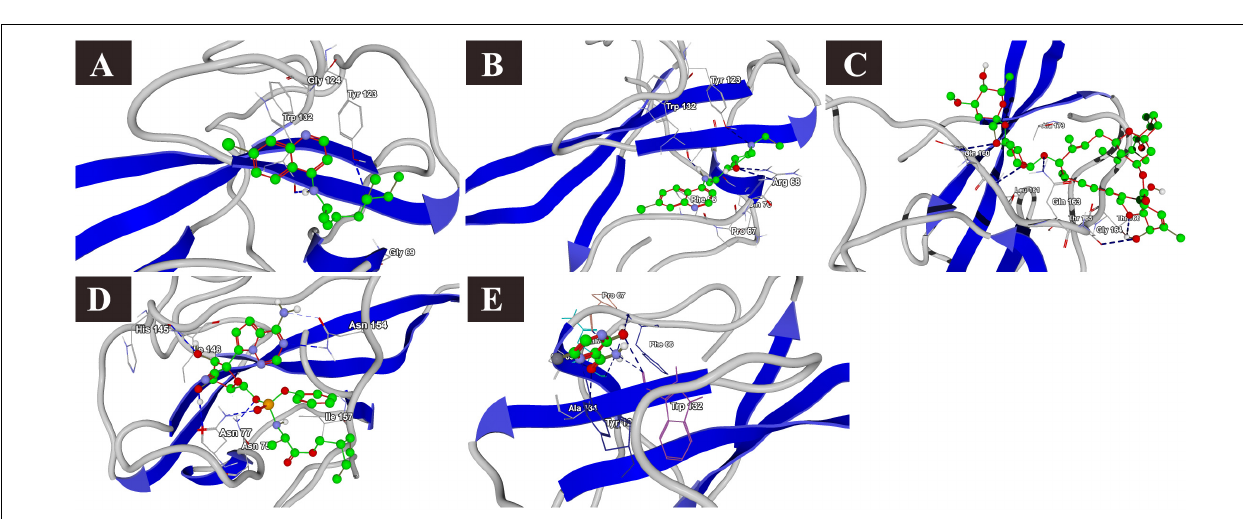
FIGURE 6 | Binding interactions of selected drugs with SARS-CoV-2 M protein. (A) chloroquine, (B) hydroxychloroquine, (C) ivermectin, (D) remdesivir, and (E) favipiravir.